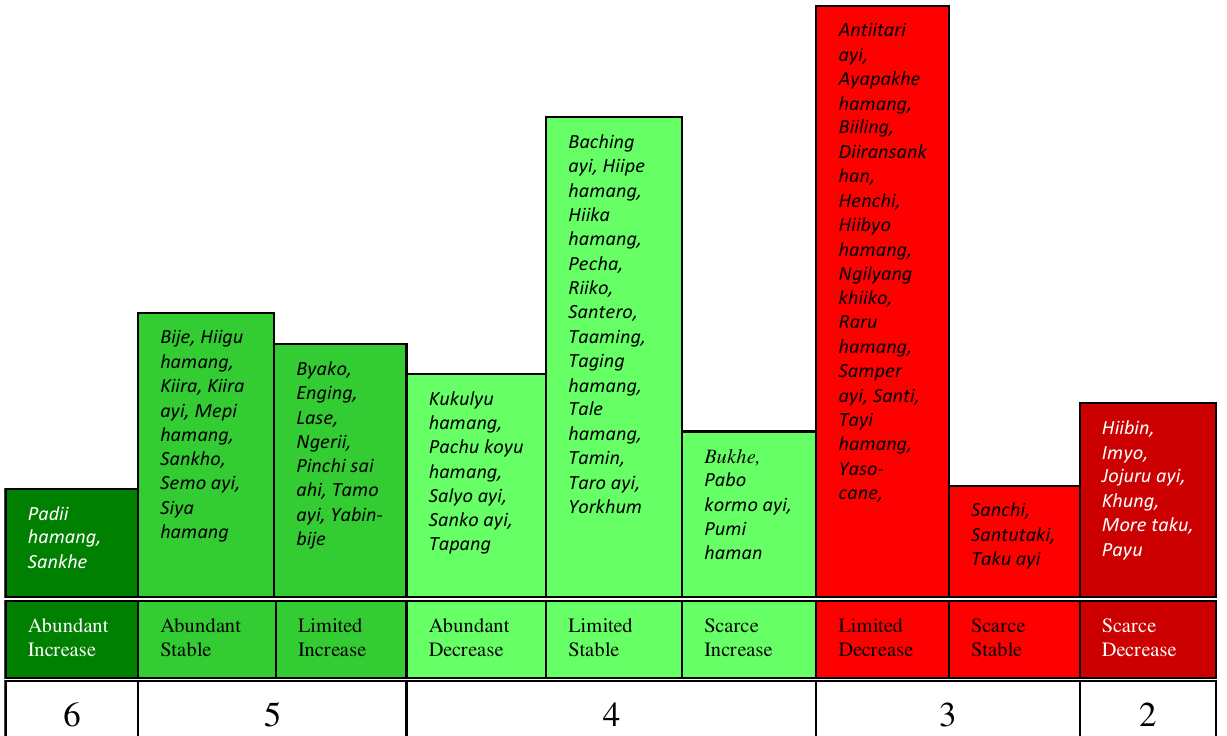
Fig. 5 Group of species as per conservation vulnerability matrix (Abundant-Increase --------> Scarce-Decrease) and index value (6------->2)